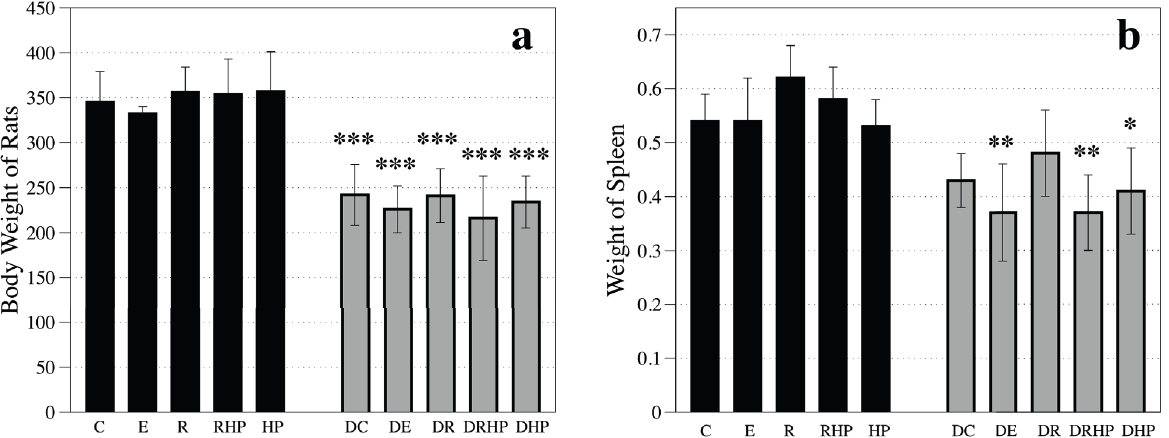
Figure 4 - Weight of non-diabetic and diabetic rats treated with free and resveratrol-hydroxypropyl-β-cyclodextrin administration. ( a ) Body weight ( b ) Weight of Spleen. data are mean ± standard deviation (Sd) for 5-7 animals in each group. data from body weight are expressed as g. C (Control), E (Ethanol), R (Resveratrol), RHP (Resveratrol- hydroxypropyl-β-cyclodextrin), HP (Hydroxypropyl-β-cyclodextrin), DC (Diabetic control), DE (Diabetic ethanol), DR (Diabetic resveratrol), DRHP (Diabetic Resveratrol- hydroxypropyl-β-cyclodextrin) and DHP (Diabetic Hydroxypropyl-β-cyclodextrin). *p < 0.5; ** p < 0.01; *** p < 0.001 compared to non-diabetic control (one-way ANOVA followed by Tukey